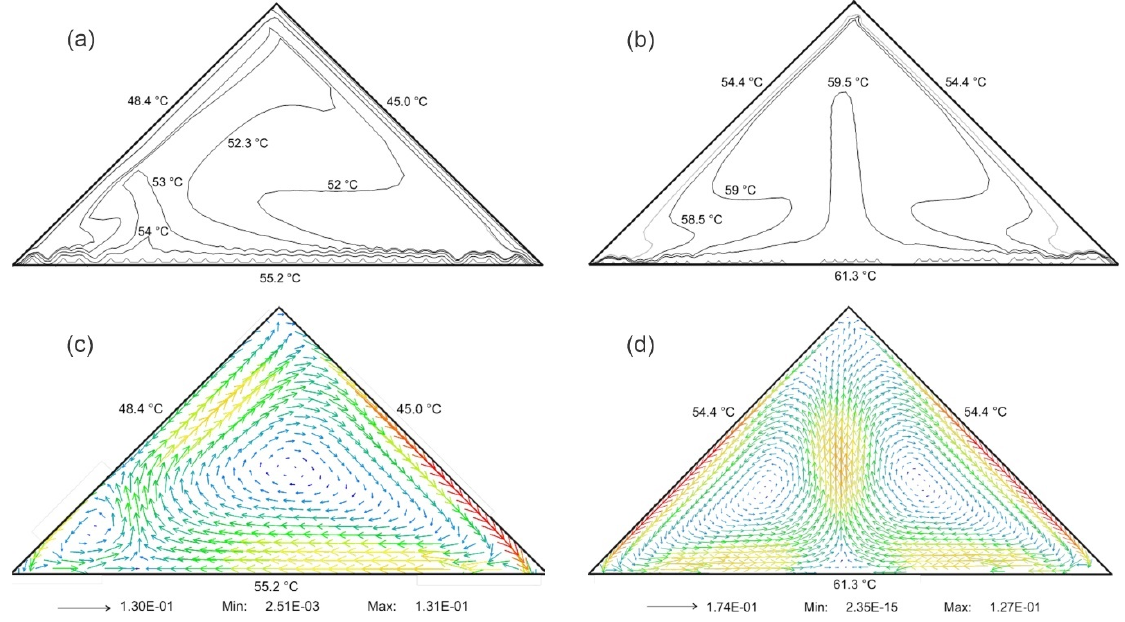
Figure 7. Computer simulator of the thermal performance of a double ‐ slope condensing cover solar still.